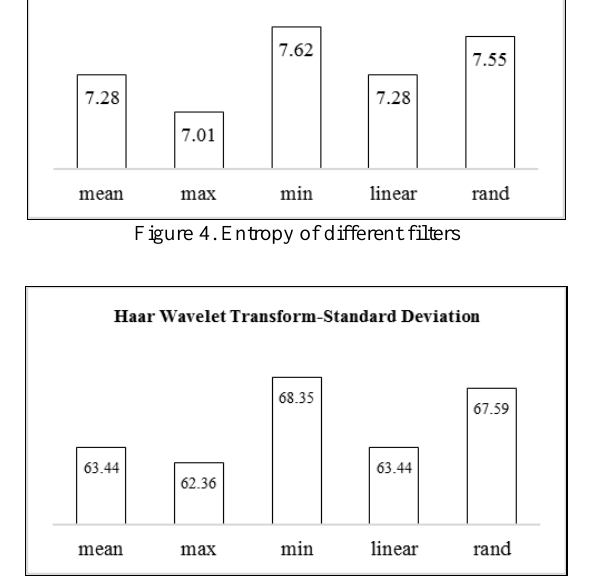
Figure 5.Standard deviation of different filters